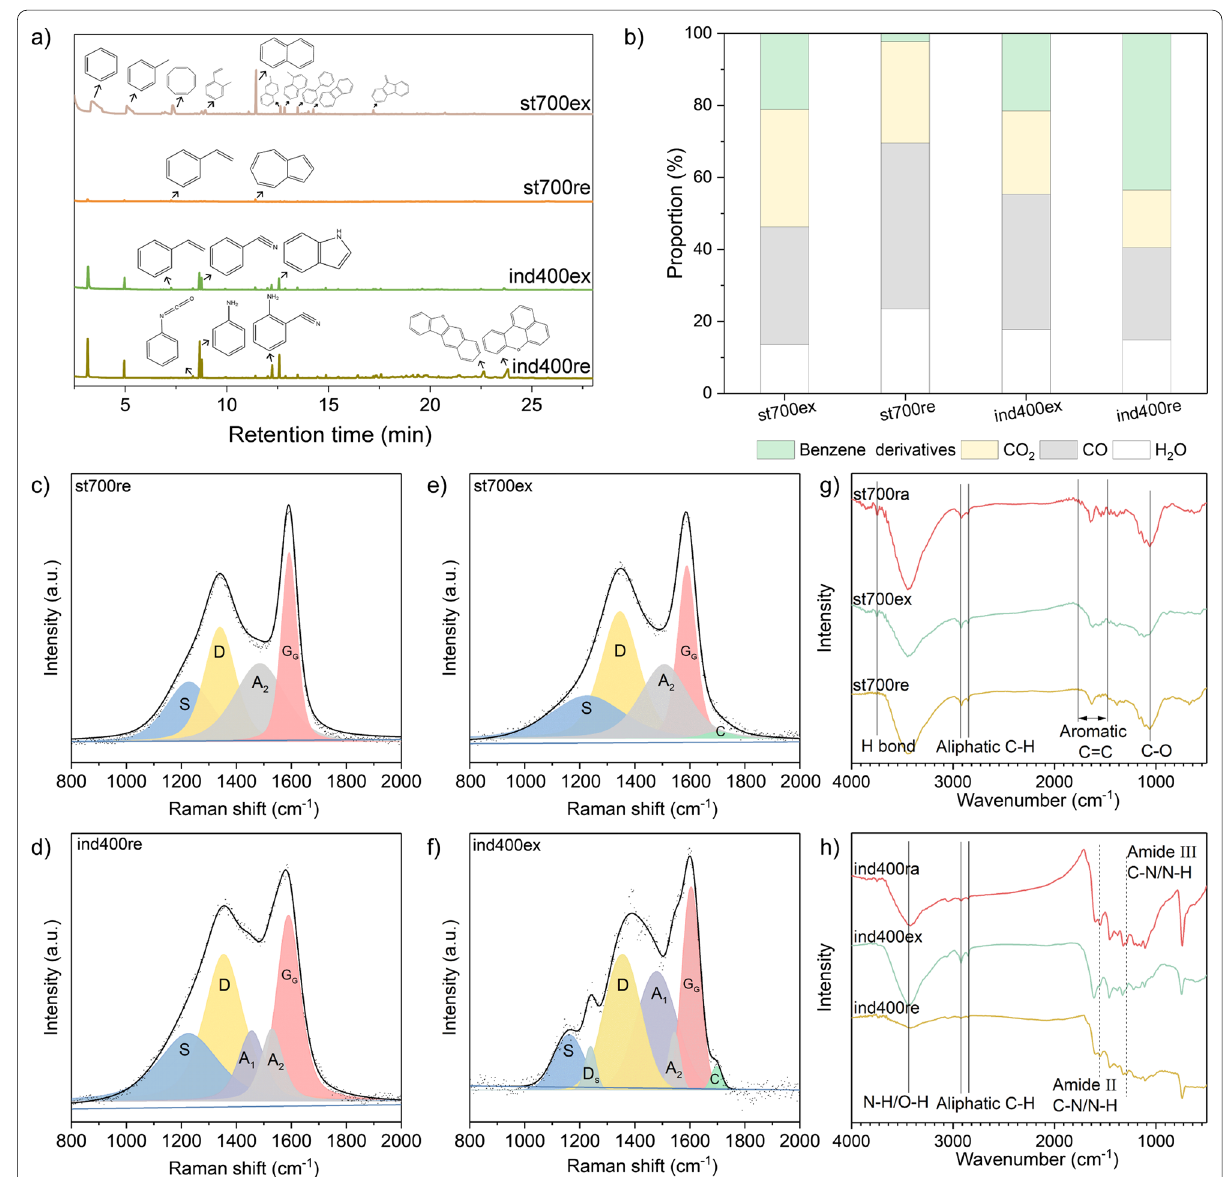
Fig. 6 Ex-situ structure information of exfoliated and residual chars. a The Total Ion Chromatograms (TICs) of pyrolysis products (except for inorganics) from exfoliated and residual char fractions. b The proportion of gaseous fractions in the pyrolysis products. c – f Raman spectra and g – h FTIR of chars: “st” and “ind” represent chars derived from starch and indigo dye, respectively. The suffix number represents pyrolysis temperature. “ex” and “re” stand for exfoliated and residual chars,